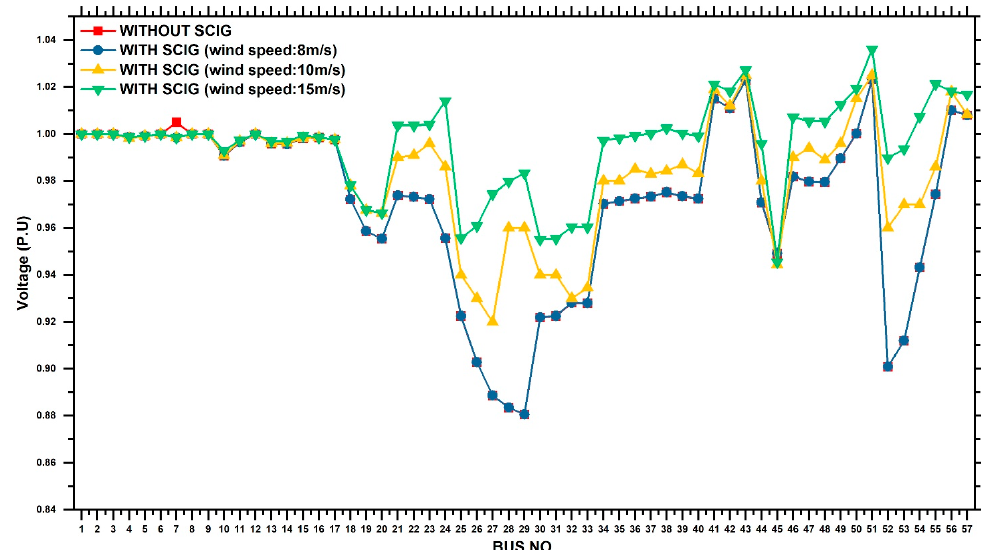
Figure A1. Comparison of DFIG output voltage with different wind speeds.